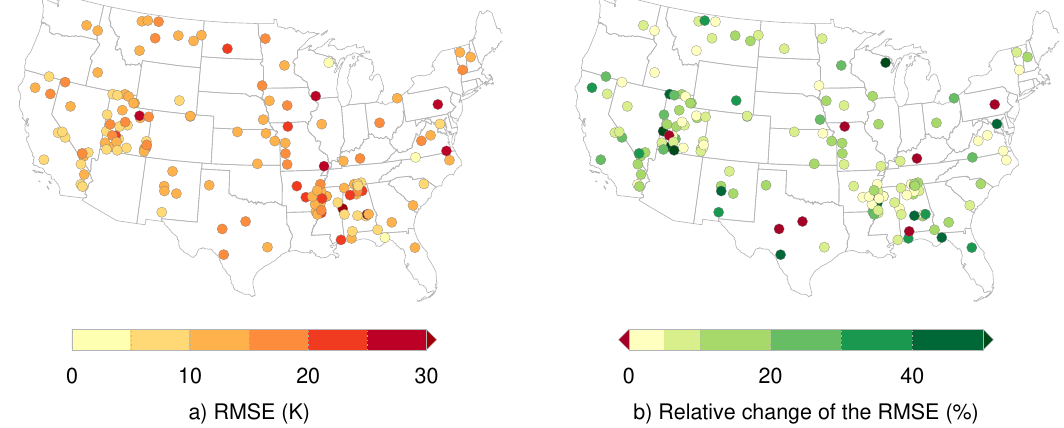
Figure 6. ( a ) RMSE between CoSMOP and L-MEB during the period April 2010 and March 2015; ( b ) percentage changes between the RMSEs from SMOS and CoSMOP with respect to the RMSE from SMOS (positive values indicate an improvement compared to